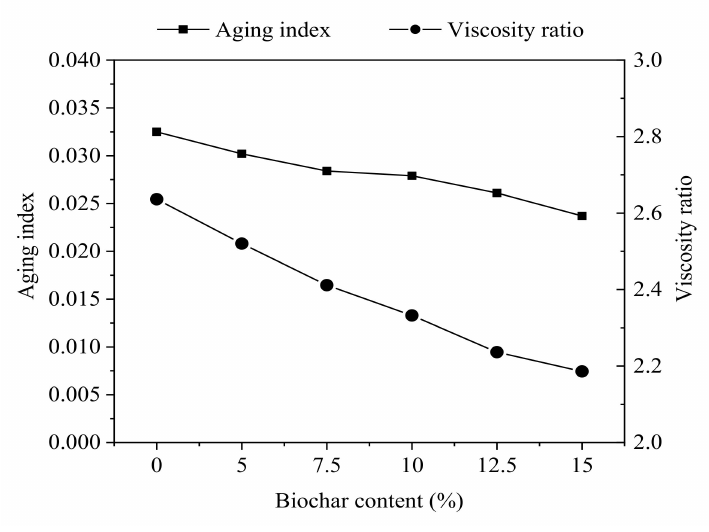
Figure 2. Aging index and viscosity ratio of biochar modified asphalt binder.